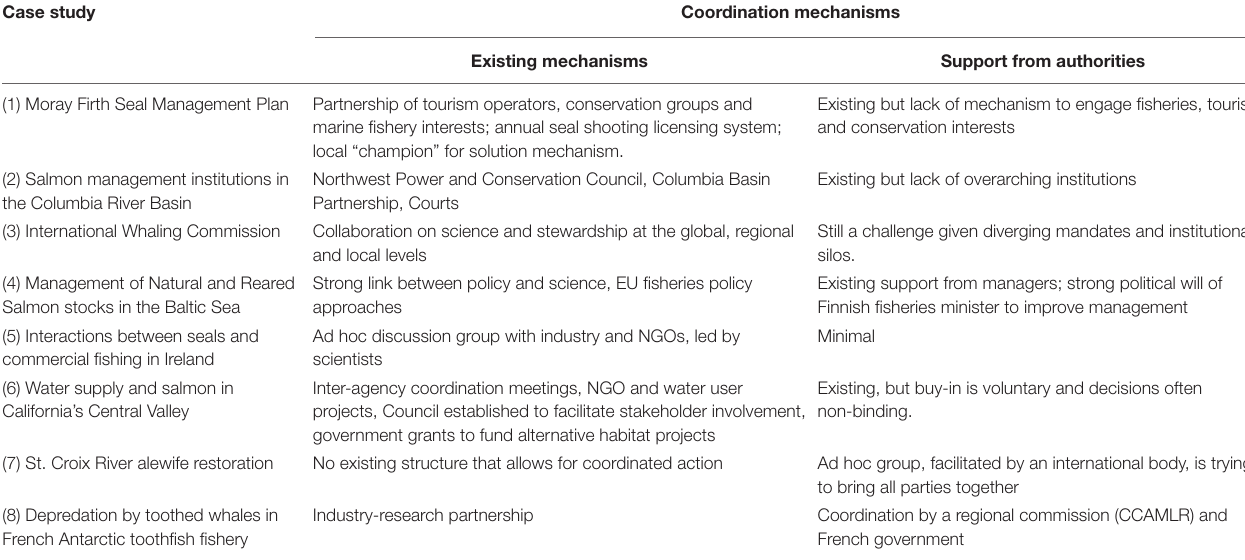
TABLE 5 | Case studies – Coordination mechanisms. Case study